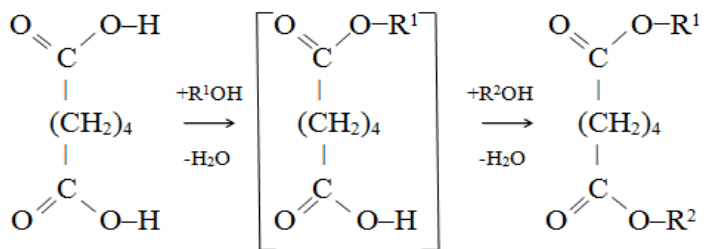
Table 1. Physicochemical properties of butyl phenoxyethyl